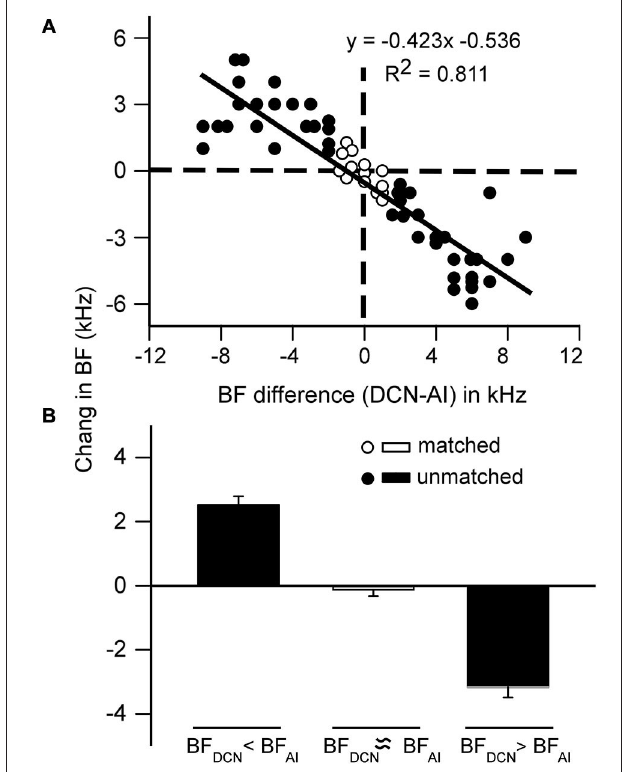
FIGURE 4 | Frequency-specific changes in the BF of DCN neurons after contralateral cortical stimulation . (A) The degree of change was systematically correlated to the BF difference between the AI and DCN neurons. Open circles, BF shift of neurons with matched BF; filled circles, BF shift of neurons with unmatched BF. (B) The averaged BF change after cortical stimulation. Open bar indicates the BF shift of neurons with matched BF; filled bars indicate the BF shift of neurons with unmatched BF. The error bars represent the